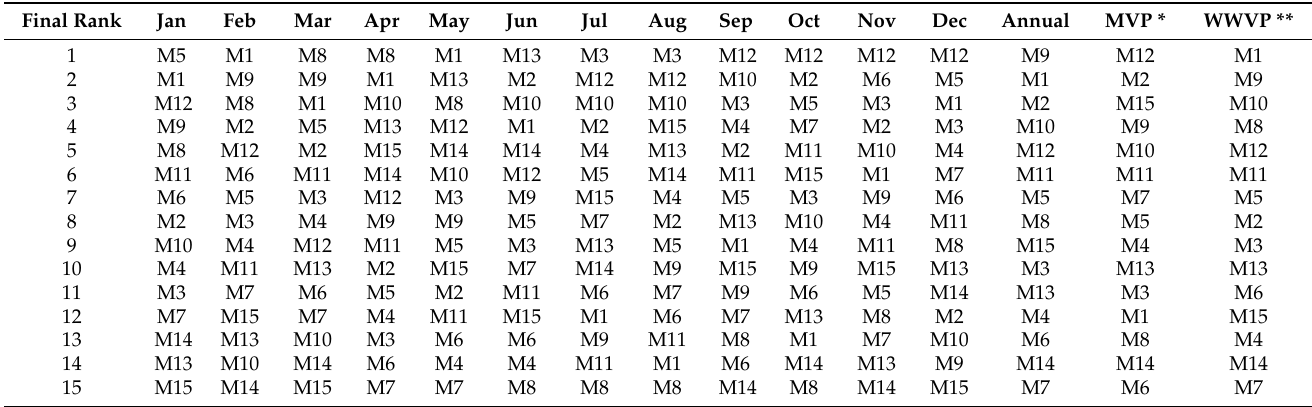
Table 3. Regional climate model ranking for months, for annual, and for vegetation periods of maize (April–October) and winter wheat (October–June) (full names of individual models are given in Table